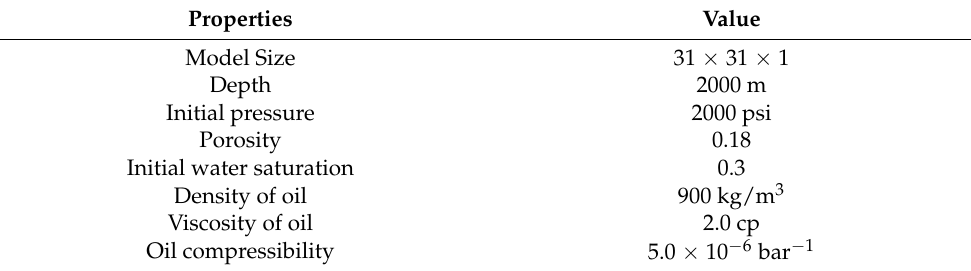
Table 2. Properties of the streak reservoir